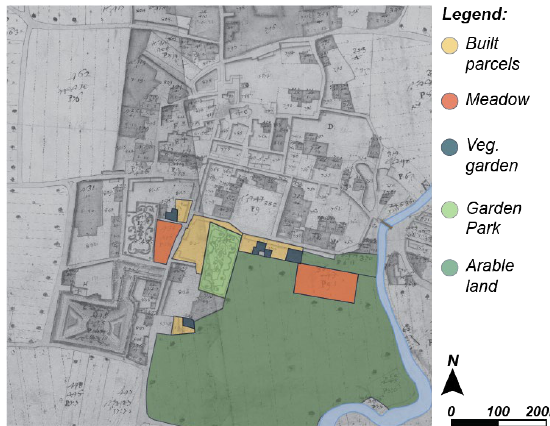
Figure 11. Map Catasto Teresiano (1721), the thematic map made by the categorisation by the owner Marquis Senator Goldone Vidone. Source: ASMi, authors